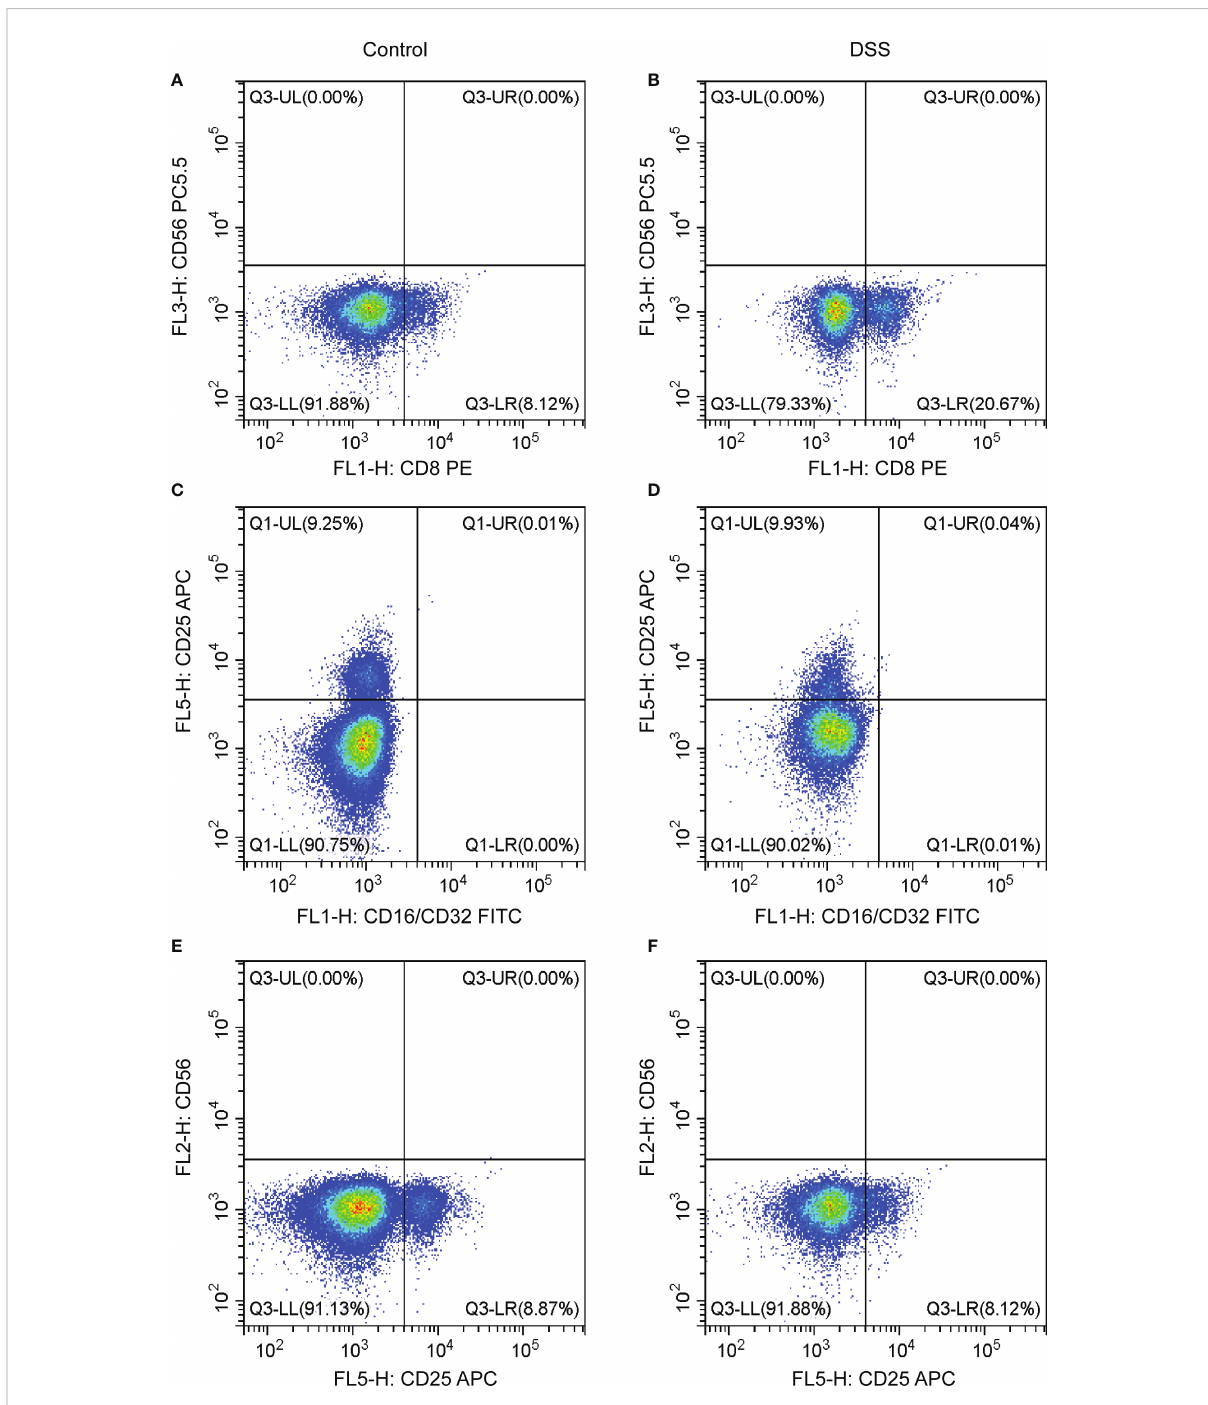
FIGURE 10 Effects of chronic in fl ammatory bowel disease (IBD) on immune cells in the spleen of mice. (A – F) The strategy of CD8, CD56, CD16/CD32, and CD25 in the DSS and control